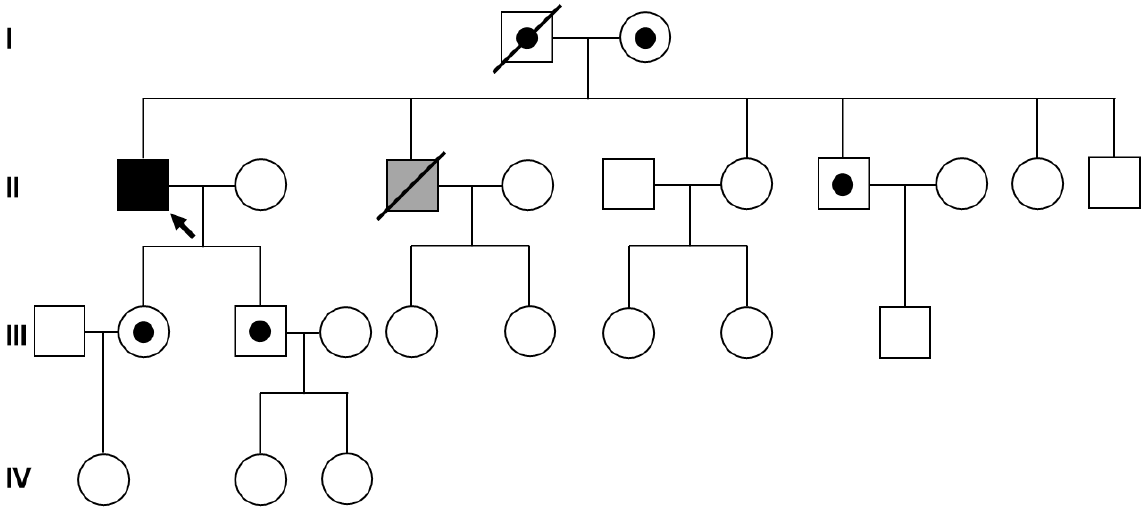
Figure 1. Pedigree analysis. The pedigrees of the proband (arrow) with Becker muscular dystrophy and his family members. The unaffected parents of the proband are obligate heterozygotes. The gray symbol indicates that the family member was clinically suspected to have dysferlinopathy but not confirmed